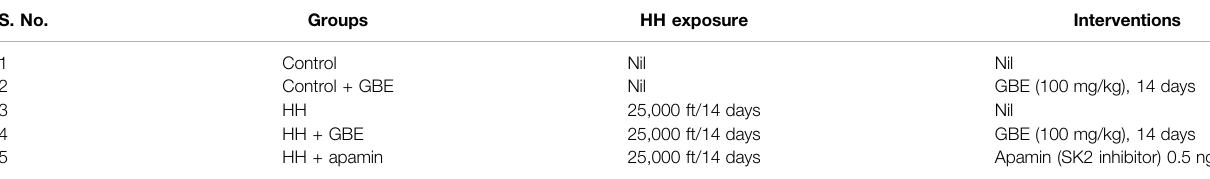
TABLE 1 | Experimental groups. S.